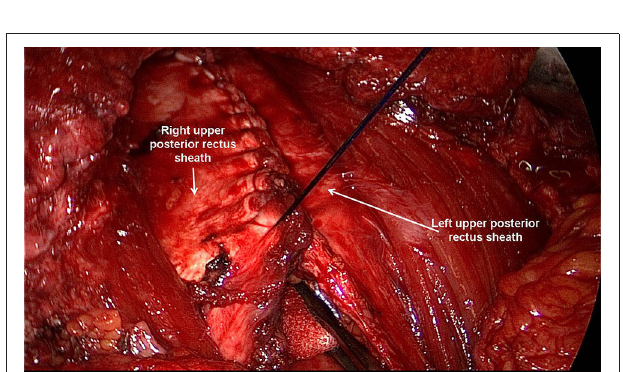
FIGURE 11 | Closure of a remaining defect in the posterior rectus sheath by a slowly absorbable mesh (Phasix ST).